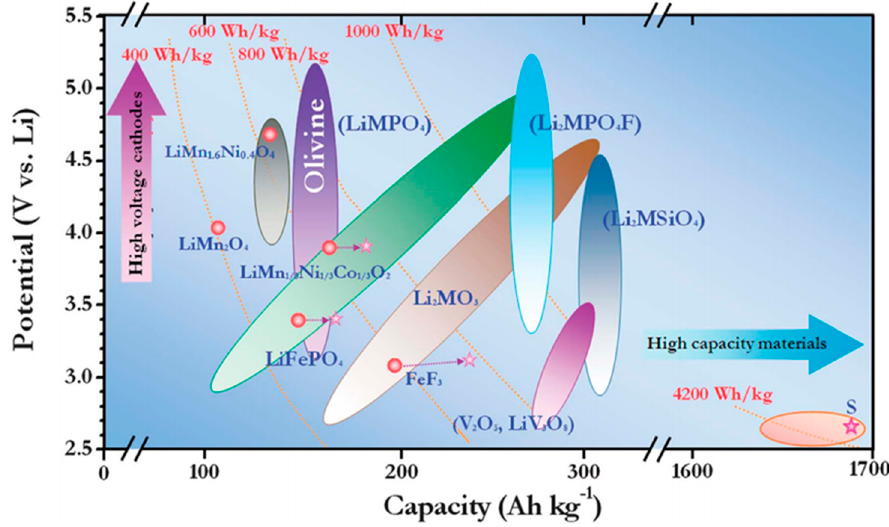
Figure 20. Schematic representation of the plot of Li-ion battery cathode material potentials vs. capacity. LiMPO 4 , Li 2 MSiO 4 and Li 2 MPO 4 F, where M ¼ Fe, Mn, Co, Ni, etc.; Li 2 MO 3 , where M ¼ Mn, Mo, Ir, Ru, etc. [236].